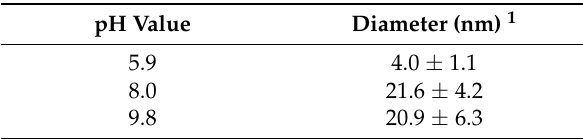
Table 4. Hydrodynamic diameter of vinylmethylether-maleic acid copolymer (VEMAC)-Tryp at different